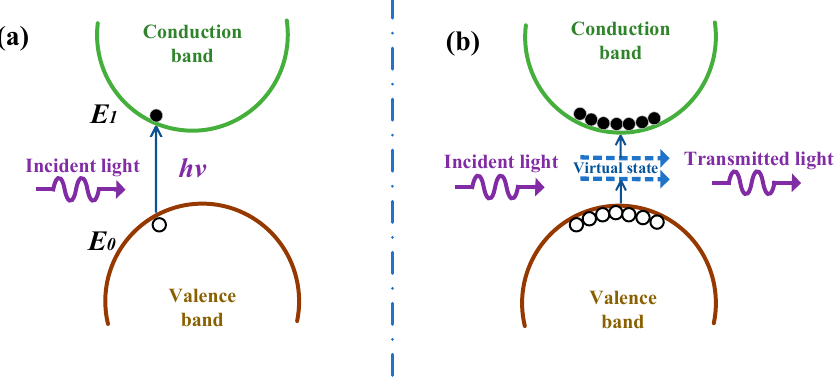
Figure 2. Open aperture Z-scan is conducted at the wavelength of 532 nm and the laser energies at ( a ) 440 μ J, ( b ) 578 μ J and ( c ) 681 μ J to obtain the normalized transmission of V 2 CT X hybrid colloid.